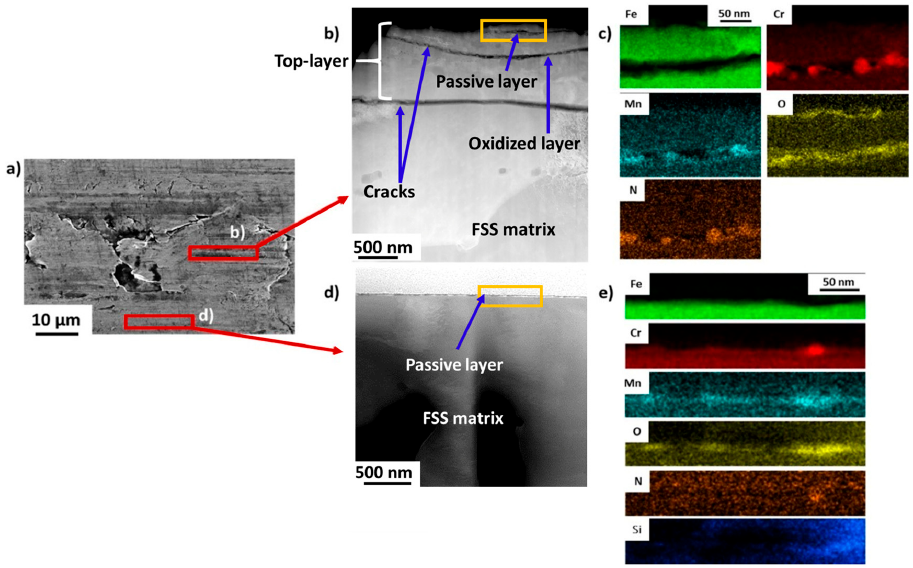
Figure 8. STEM analyses acquired on the FSS1 sample. ( a ) SEM micrograph. The two red rectangles highlight the areas which were used to prepare the TEM lamellas. ( b ) STEM-HAADF micrograph of an area affected by the GDD. The rectangle highlights the area used to perform the EDS analyses. ( c ) Corresponding EDS chemical maps. ( d ) STEM-HAADF micrograph of an area unaffected by the GDD. The rectangle highlights the area used to perform the EDS analyses. ( e ) Corresponding EDS chemical maps.